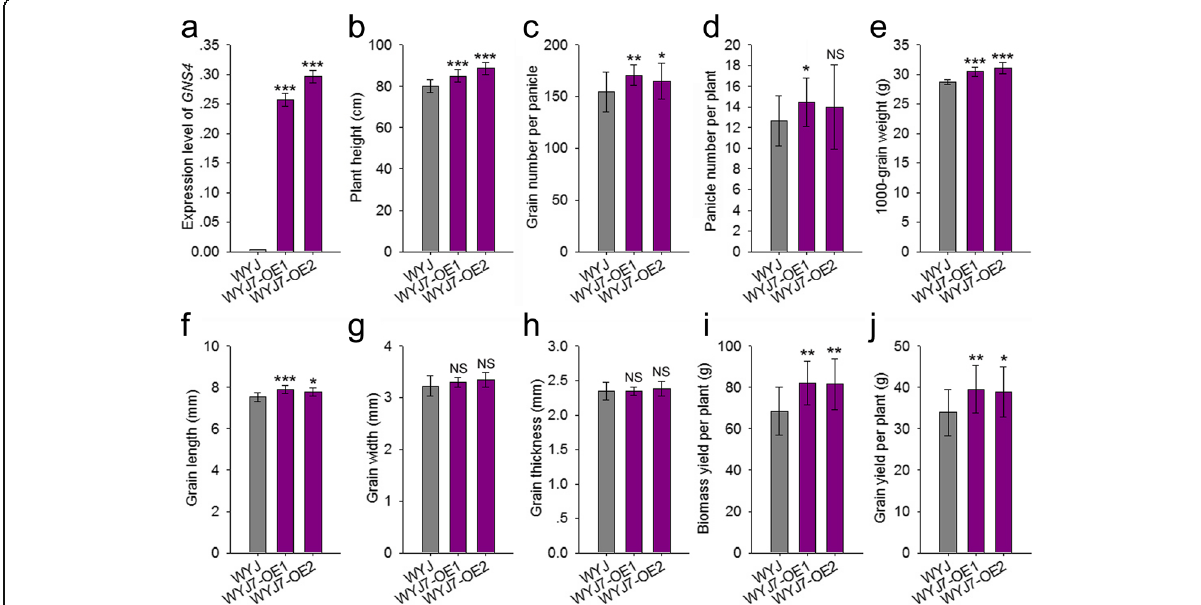
Fig. 8 Agronomic traits of GNS4 -overexpressing lines in high-yield variety Wuyunjing 7 (WYJ7) background. a GNS4 mRNA expression level of WYJ7, WYJ-OE1 and WYJ-OE2 plants. The expression level of the rice Actin gene was amplified as a control. Values are means ± s.e. of three independent experiments. b-j: Agronomic traits of WT and transgenic lines. b Plant height. c Grain number per panicle. d Panicle number per plant. e 1000-grain weight. f Grain length. g Grain width. h Grain thickness. i Biomass yield per plant. j Grain yield per plant. Traits were measured at the mature stage. Data are given as means ± s.e. ( n ≥ 10). Significant at ***0.1%, **1% and *5%. NS, not significant. WYJ-OE1 and WYJ-OE2 are two independent GNS4 -overexpressing